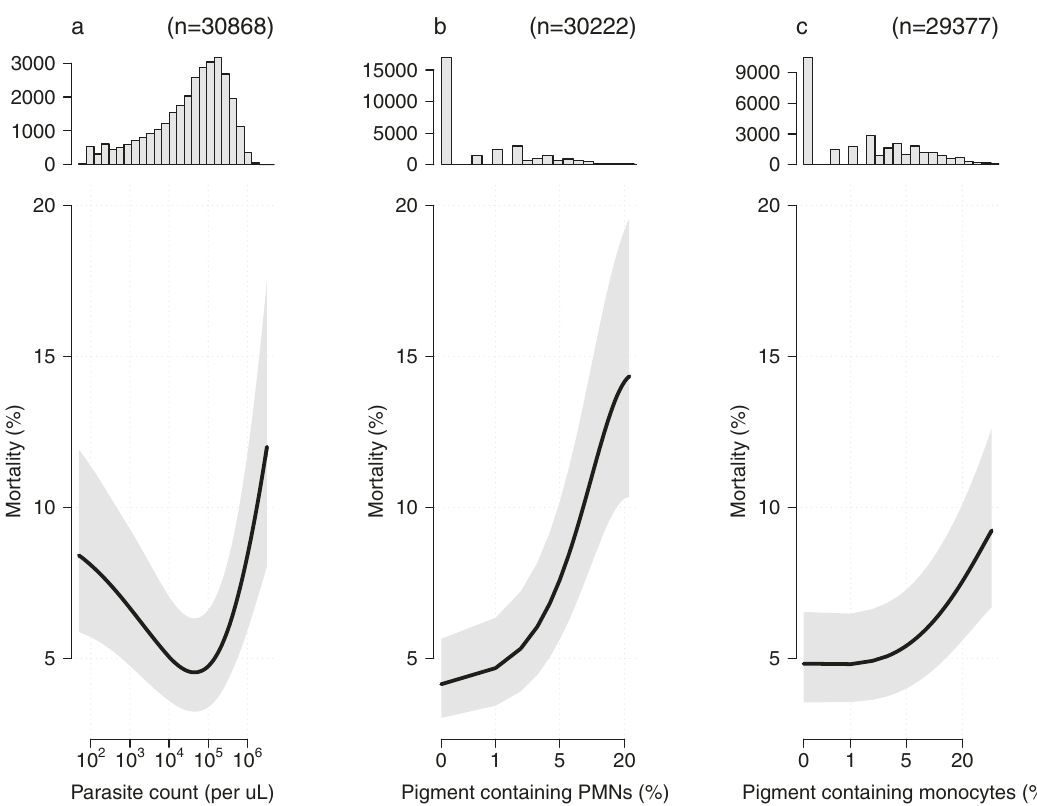
Fig. 2 | The prognostic value of quantitative microscopy cell counts in the pooled data set of >30,000 children from sub-Saharan Africa diagnosed with severefalciparummalaria. Eachpanelshowsthehistogramofquantitativecounts (top), and the relationship between the count variable and mortality (mean: black